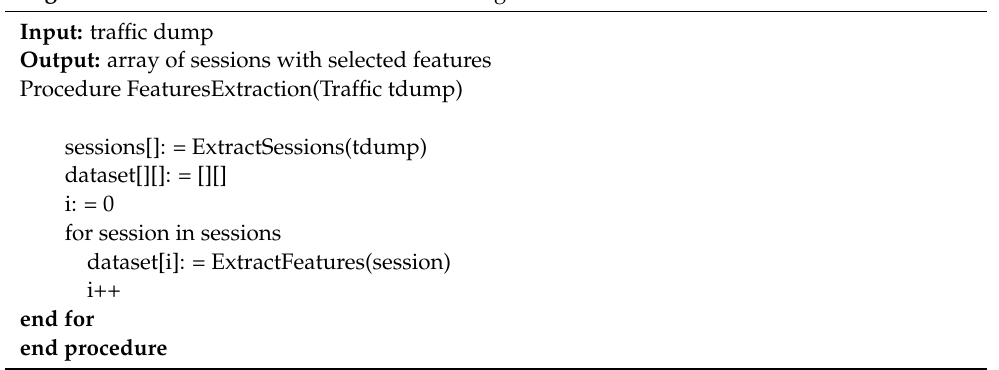
Algorithm 1. Feature extraction and selection algorithm.